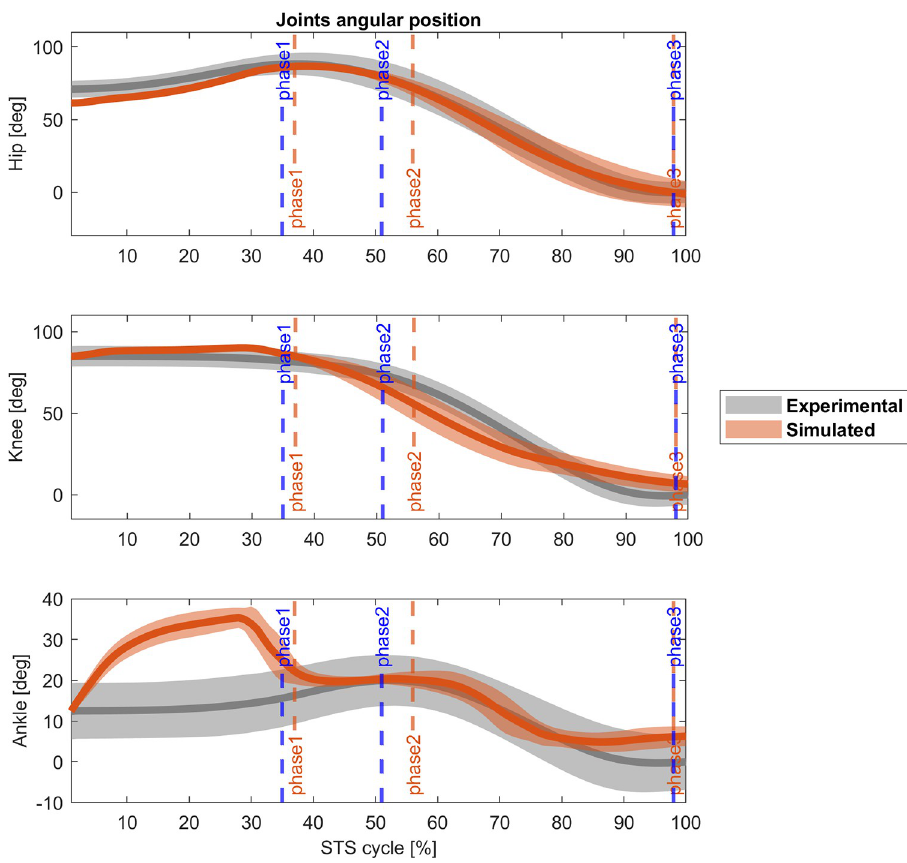
Fig 7. Experimental (grey) and 2-phases controller (orange) joint angles [deg] comparison (mean ± std). Blue vertical lines: experimental cycle times; orange vertical lines: 2-phases controller cycle times. Cross-correlation coefficient: r(hip) = 0.99 ( Δ = 0%), and r(knee) = 0.97 ( Δ = 0%), r(ankle) = 0.67 ( Δ = -8%).